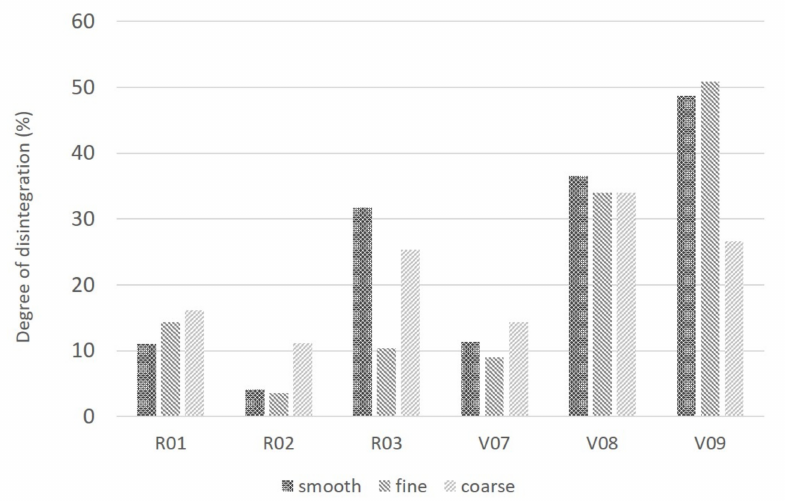
Figure 10. Comparison between sample surface structures and degree of disintegration, measured after 12-week composting period. Compositions: R01: PLA/PBS (7:3); R02: PBS/PLA (7:3); R03: PLA/PBAT (7:3); V07: PLA/PBS (7:3) plus 15 phr coarse talc; V08: PLA/PBS (7:3) plus fine talc; V09: PLA/PBS (7:3) plus